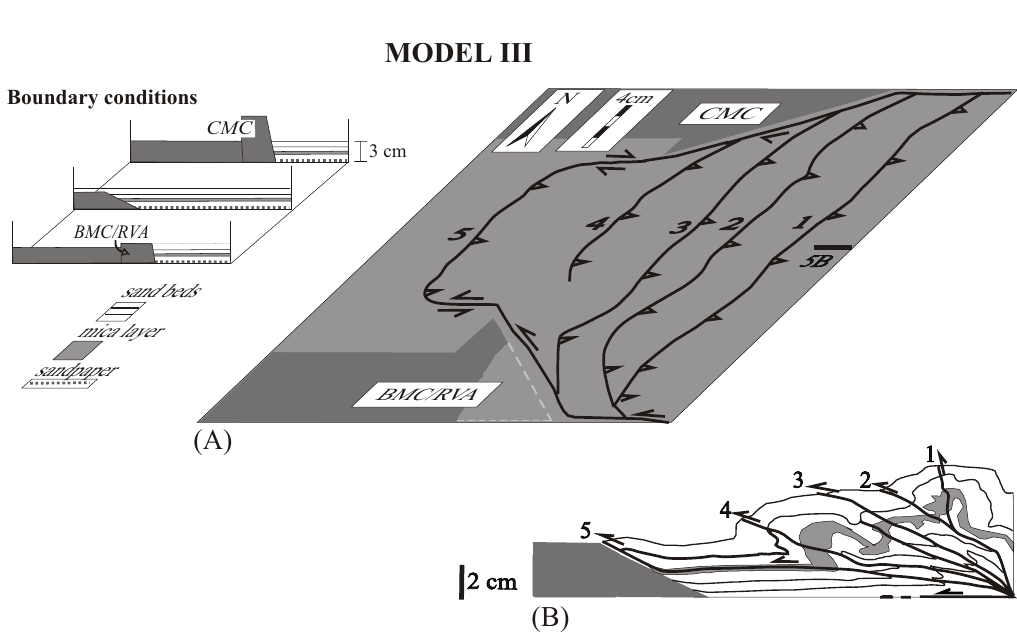
Fig. 5 – Plan-view and profile line drawings of model III, after 27% (10 cm) shortening. A – Plan-view showing the traces of thrust faults, and of oblique and lateral ramps respectively along the structural highs and to their west side. B – Vertical section through the central domain displaying thrust 5 (the youngest fault) with a staircase trajectory. The dip angle of the older faults varies because of the mobile mica crystal layer. The plastic behavior of the mica layer (dashed, in the line drawing) is reflected by development of thickened and thinned domains. Numbers indicate the order of fault formation. CMC – Caetés Metamorphic Complex; BMC/RVA – Bação Metamorphic Complex/Rio das Velhas